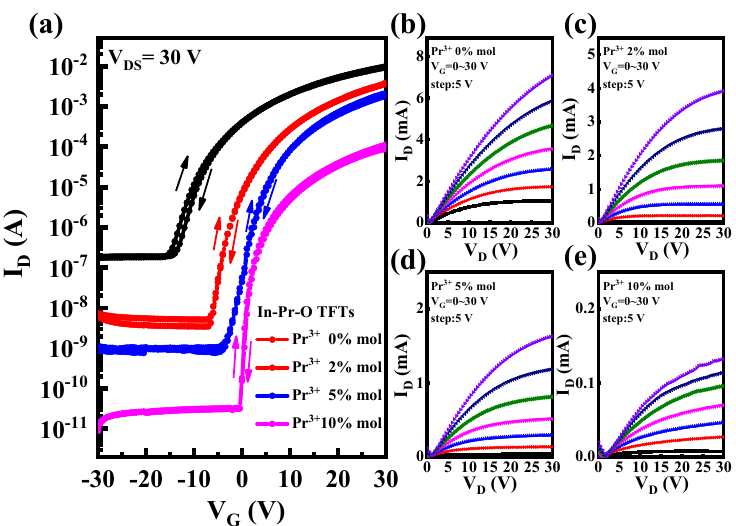
Table 1. The undoped In 2 O 3 device has high mobility ( μ ) of 28.15 ± 1.27 cm 2 /Vs; however,